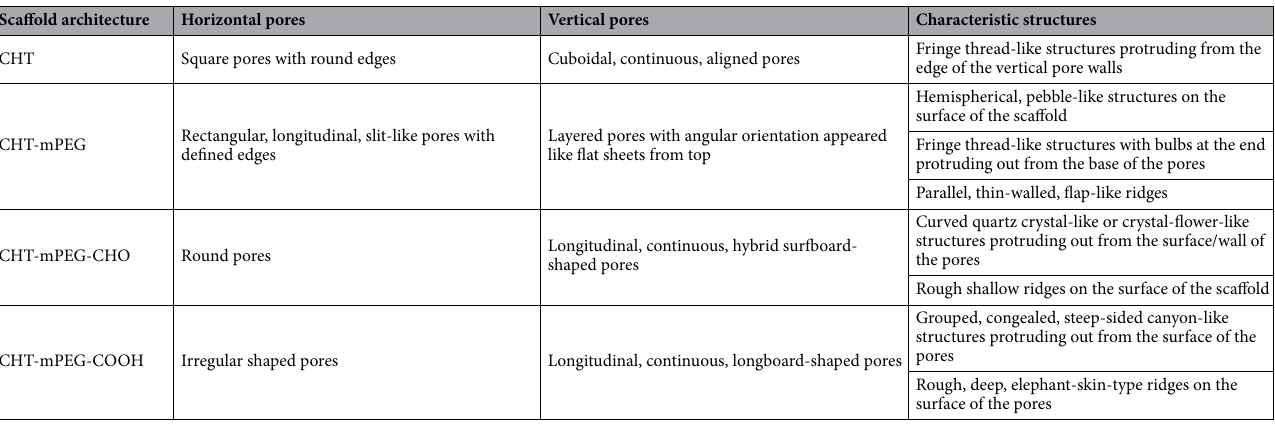
Table 3. Qualitative, observational and comparative analysis of the CHT/mPEG